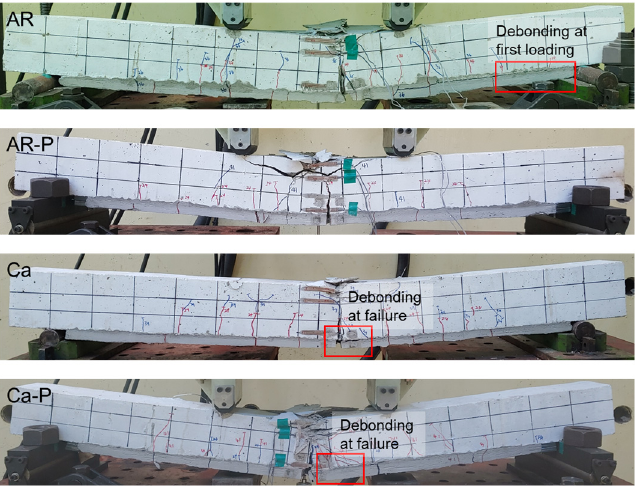
Figure 3. The failure mode of TRM strengthened RC beam.